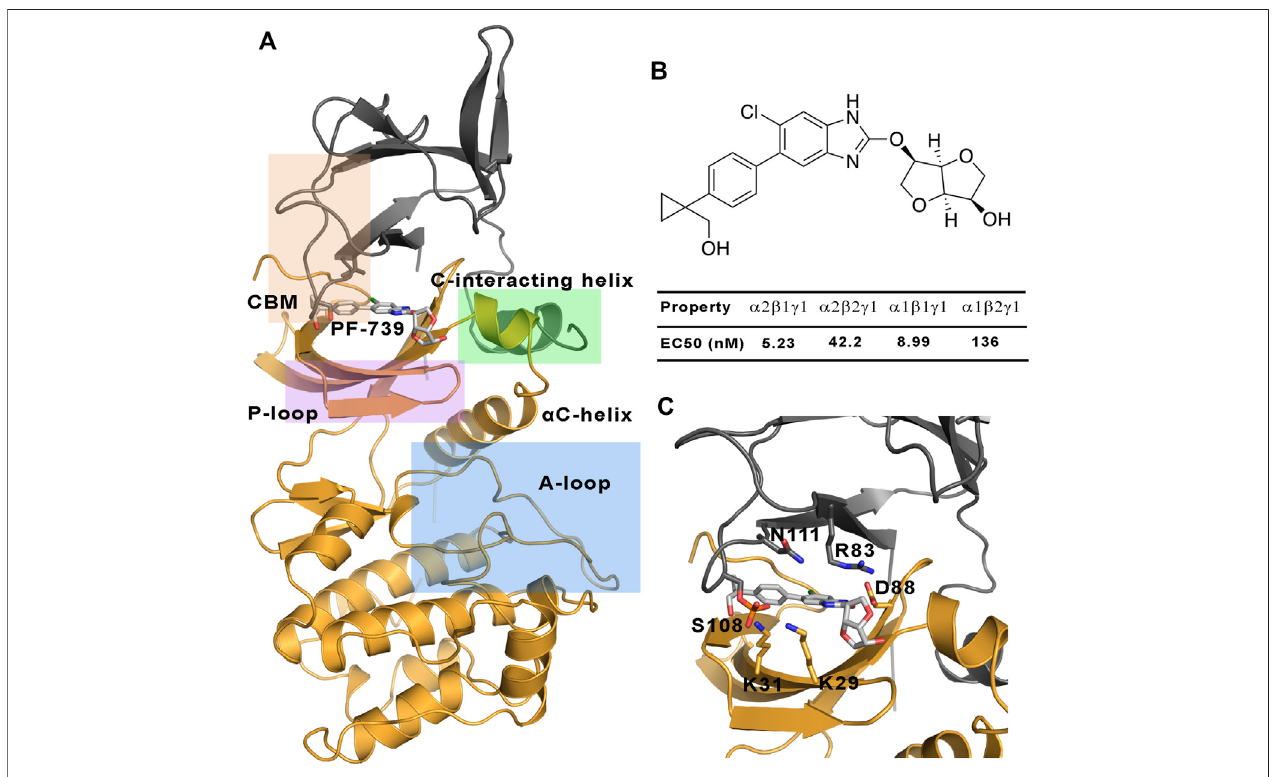
FIGURE 1 | (A) Representation of the system selected for the study of the direct activation mechanism, which is composed of α 2 (yellow cartoon) and β 1-/ β 2- subunits (grey cartoons) . The most important regions of these subunits are highlighted: P-loop (purple) , activation loop (A-loop, cyan ), CBM domain (orange) and C-interacting helix (green) . (B) Chemical structure of PF-739, together with the experimental data obtained in Cokorinos et al. (2017) for the half maximal effective concentration (EC 50 ). (C) The activator bound to the ADaM site, with selected residues of the ADaM site shown as